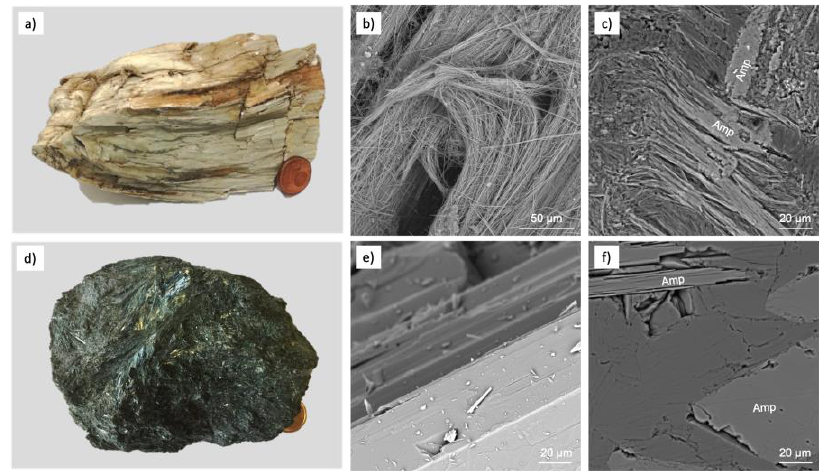
Figure 1. Close up photographs of tremolite–actinolite vein ( a ) and schist ( d ). SEM microphotographs of amphiboles (Amp) of the tremolite actinolite series of fibrous and asbestiform habit ( b , c ) and fibrous but nonasbestiform habit ( e , f ). Scale bar in microphotographs; high vacuum: 20 kV; detector: back-scattered electrons.